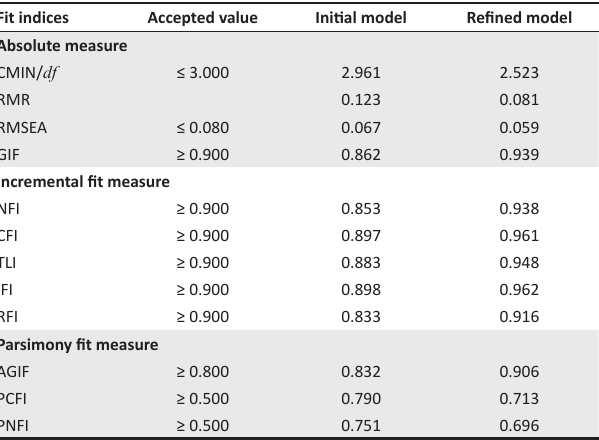
TABLE 2: Result of measurement model